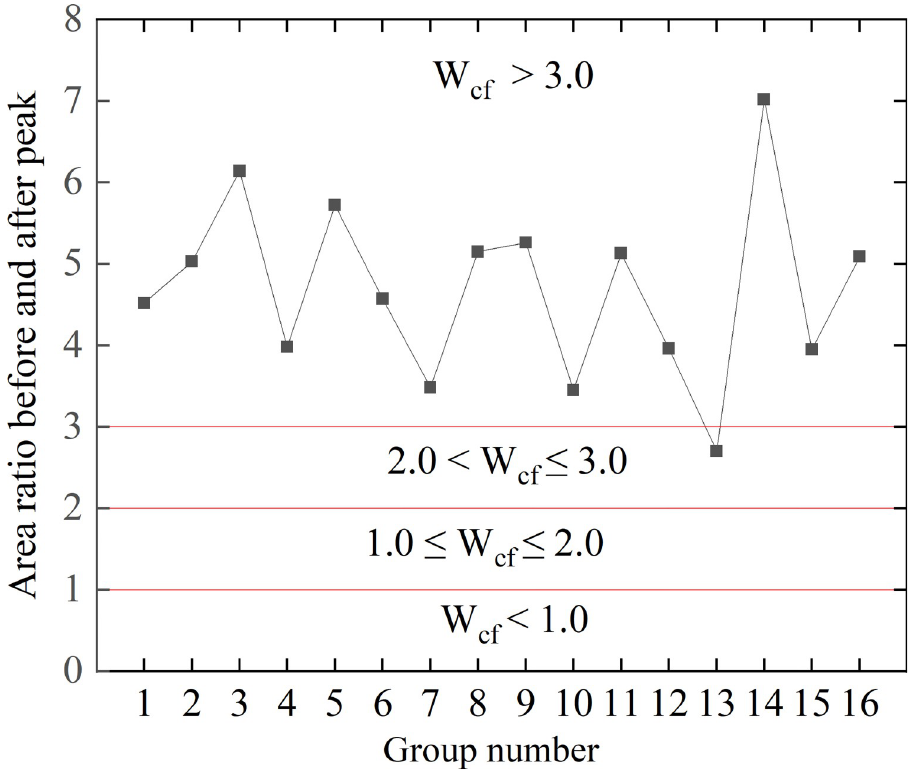
Fig 7. Determination of rockburst tendencies based on the area ratio before and after